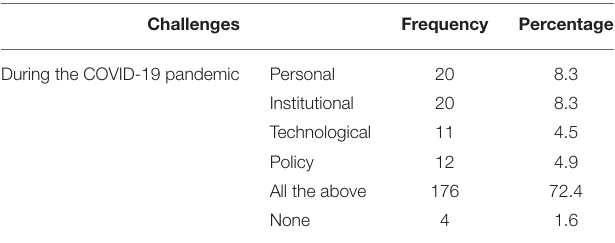
TABLE 3 | Challenges faced by health